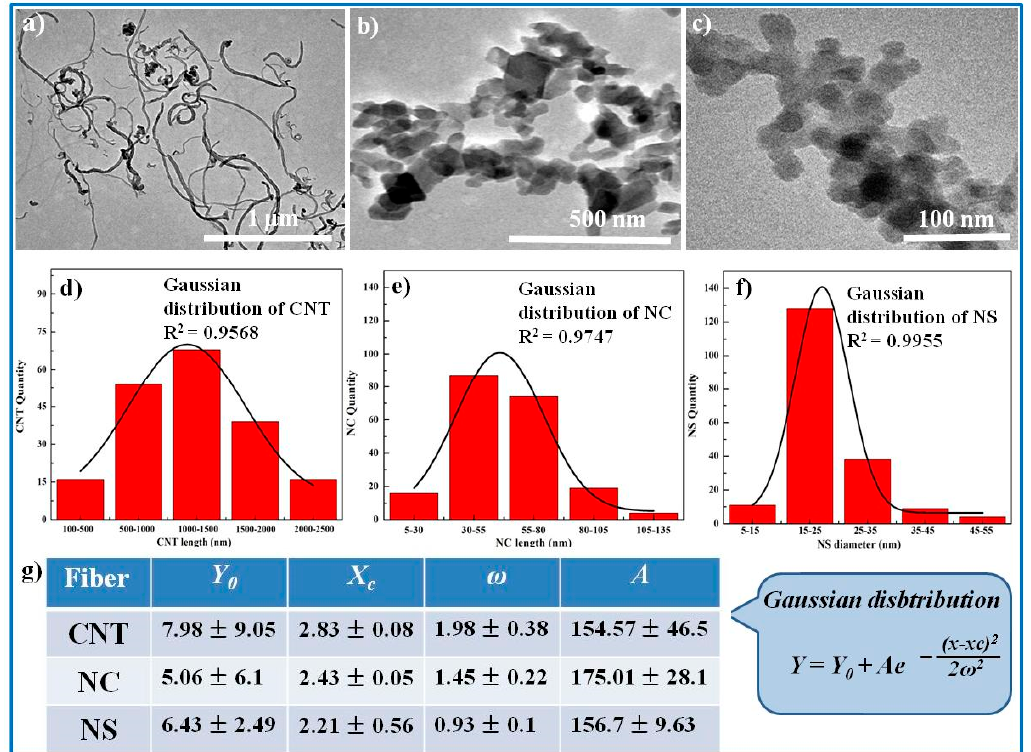
Figure 2. The morphology of inorganic nanoparticles: TEM pictures of ( a ) CNT, ( b ) NS, and ( c ) NC, respectively; the dimension histogram of ( d ) CNT, ( e ) NS, and ( f ) NC, respectively; and ( g ) the statistical parameters in Gaussian distribution for inorganic nanoparticles.